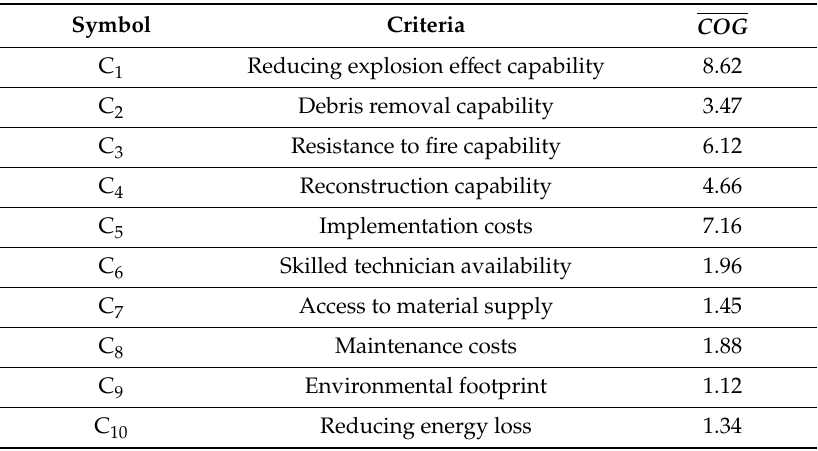
Table 6. Final criteria ranking for